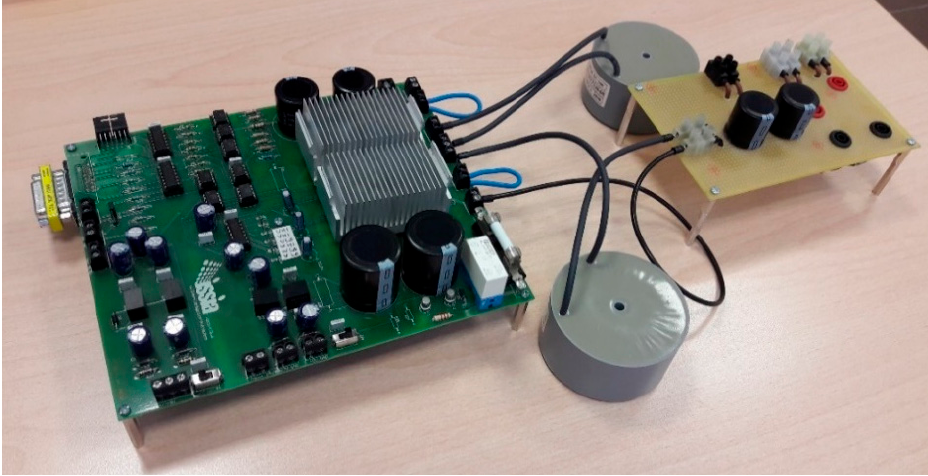
Figure 9. Picture of the realized Split-pi converter.